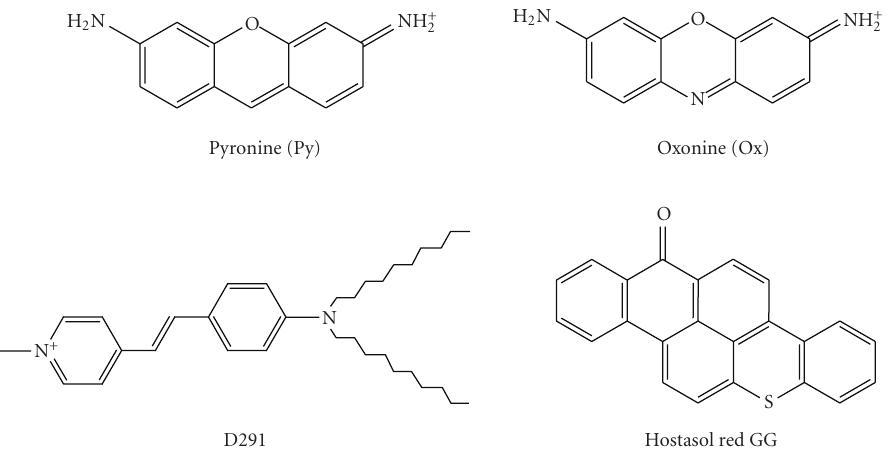
Table 1: Summary of the structural formulae of dyes presented in this